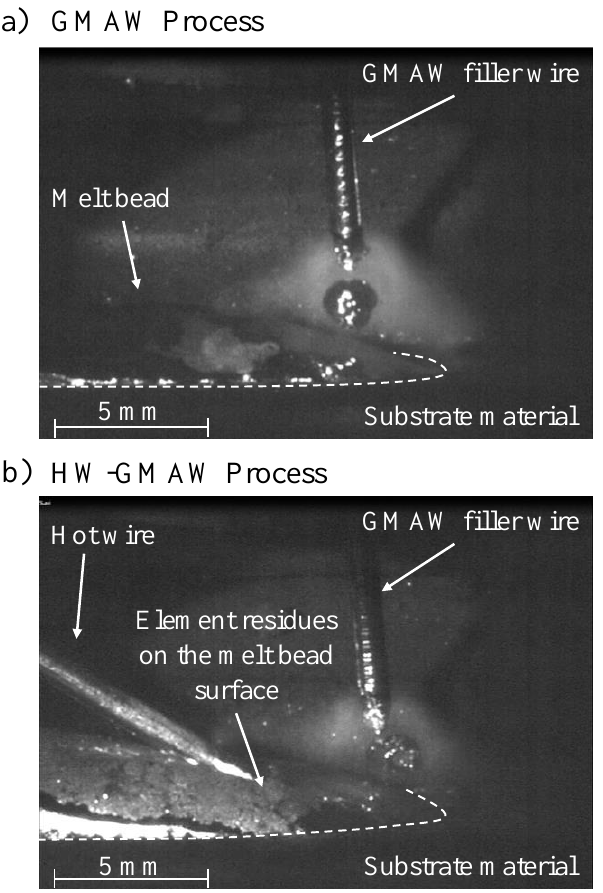
Figure 11. Appearance of element residues on the melt bead surface due to hot wire application during GMAW. ( a ) Melt bead formation during GMAW ( b ) HW-GMAW reveals residues on the melt bead surface.